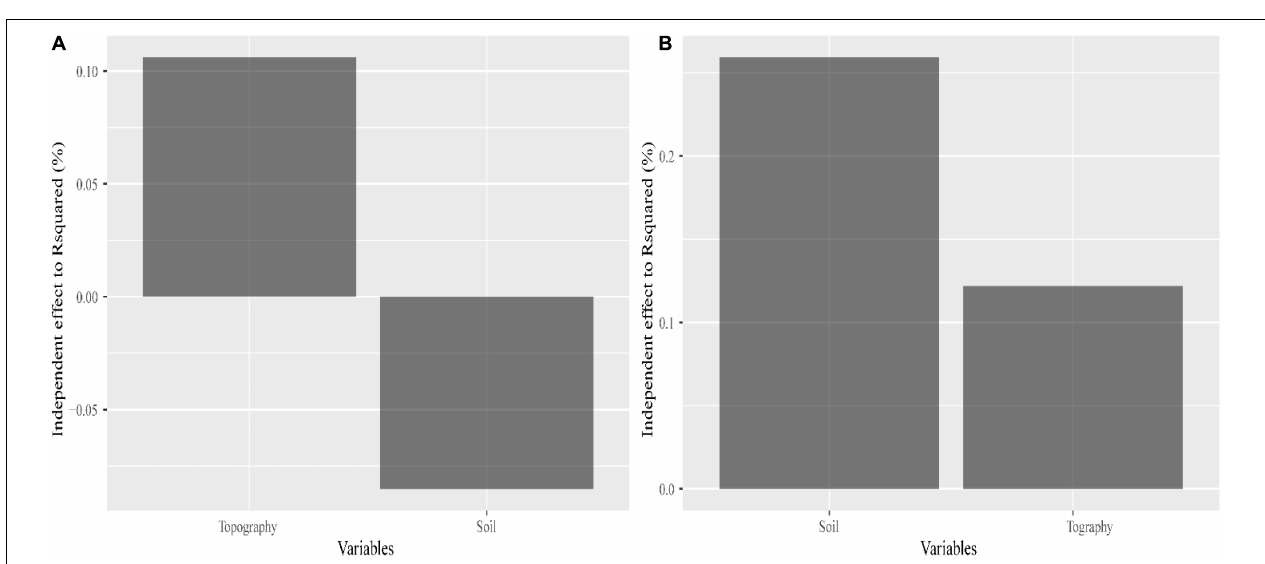
FIGURE 3 | Contributions made by a single explanatory variable to species diversity (A) and genetic diversity (B) .